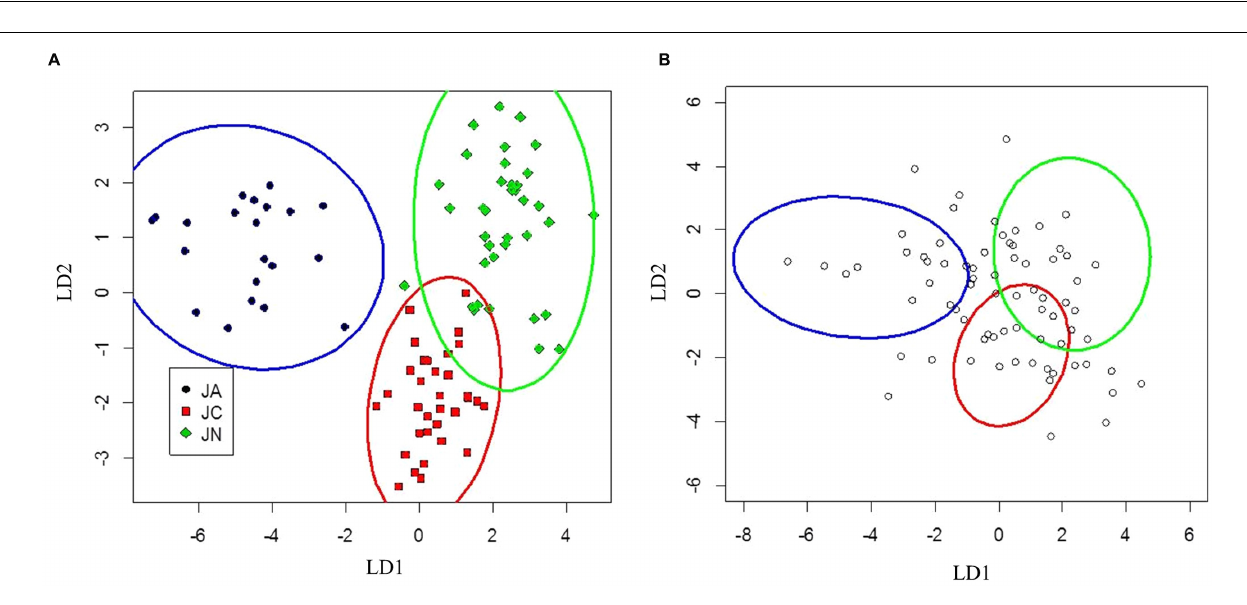
FIGURE 4 | Canonical discriminant analysis separating J. ailantifolia Carr. var. cordiformis , J. cinerea L., and J. nigra L. based upon functional adaptive traits (A) . J. × bixbyi Rehd. individuals were applied to the parameter space as Figure 3 (B)